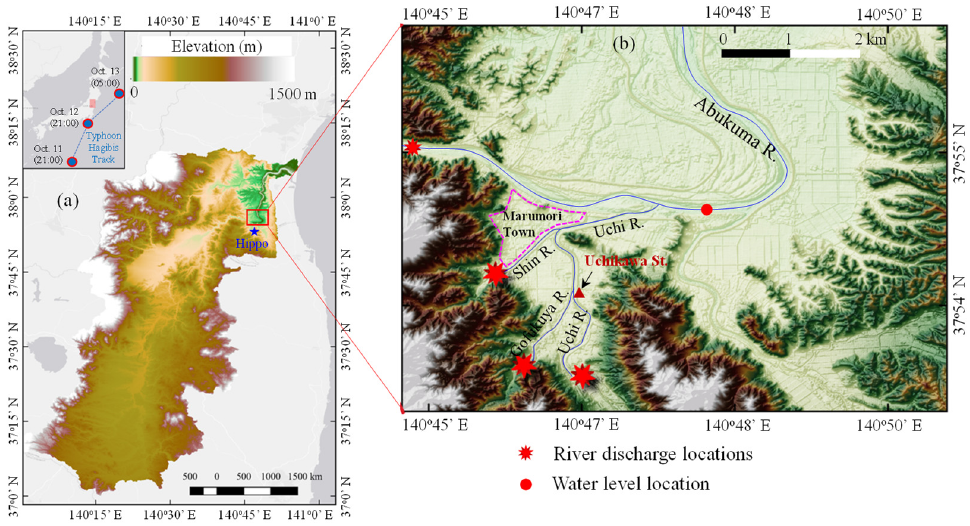
Figure 1. ( a ) Elevation map of Abukuma R iver Basin, ( b ) Location of the Marumori